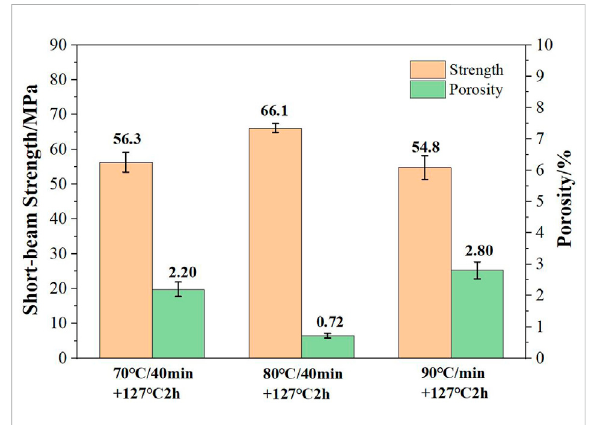
FIGURE 6 Effect of initial curing temperature on mechanical properties and void content of